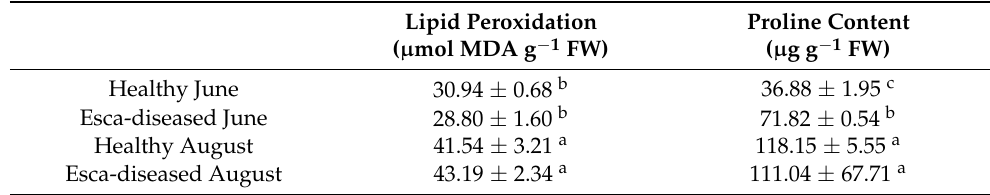
Table 4. Effect of esca on the membrane lipid peroxidation and proline content in leaves of Vitis vinifera cv.